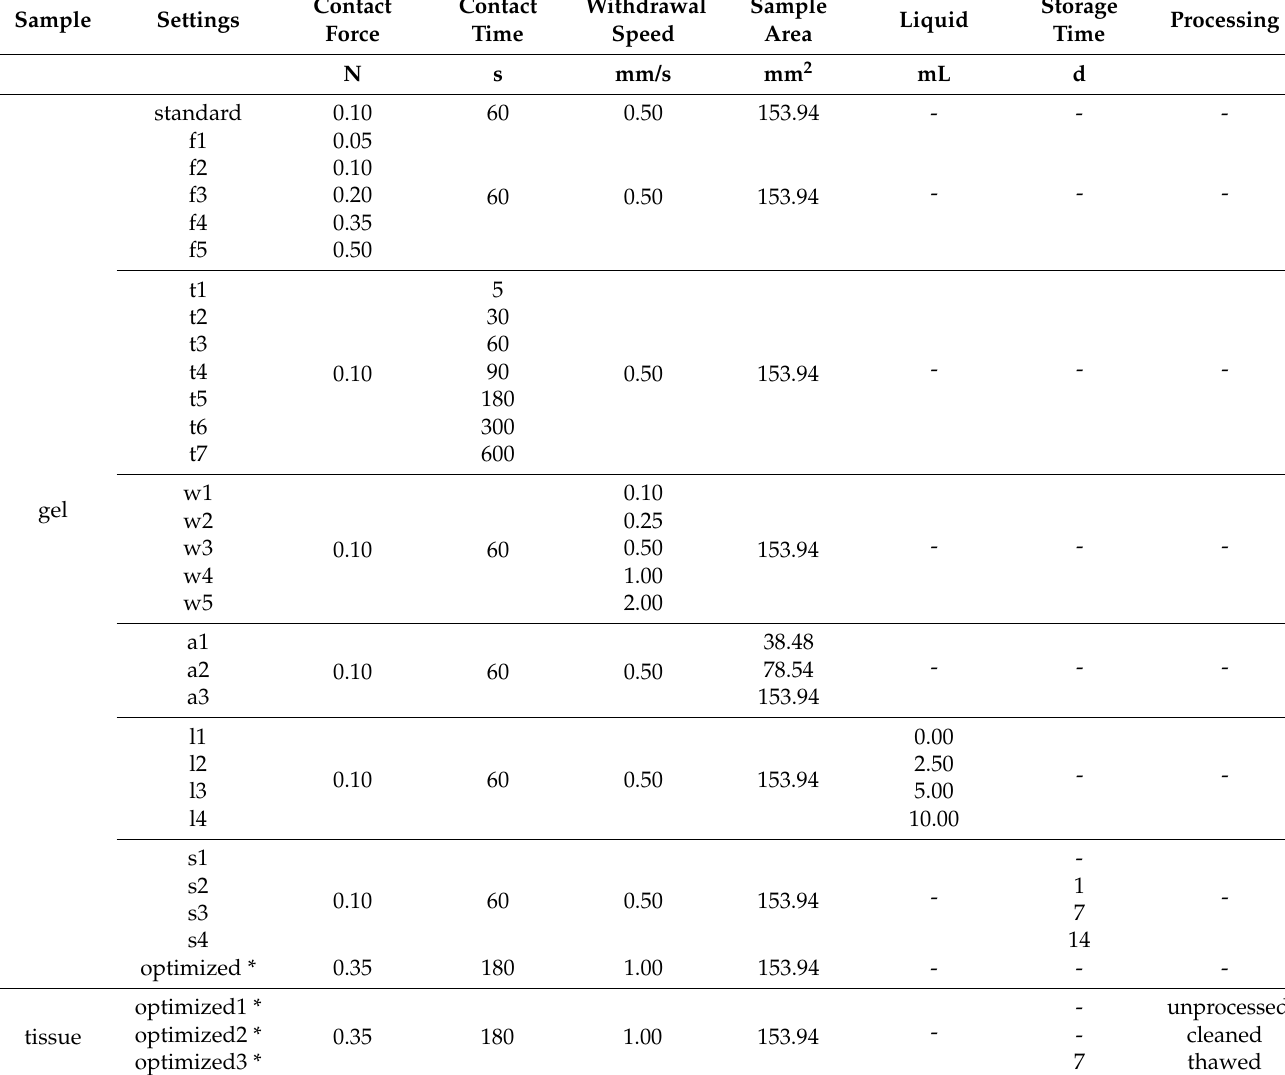
Table 1. Measurement parameters of the in vitro experiments as well as the ex vivo